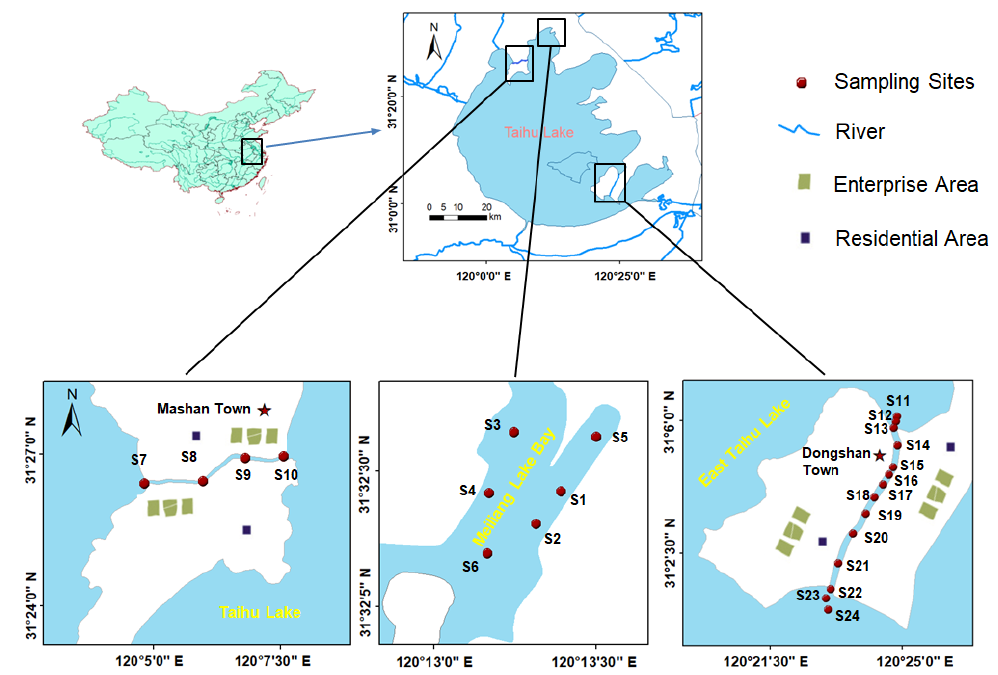
Figure1. Location of sampling sites in the lake bay and adjoining river of Taihu Lake. Figure 1. Location of sampling sites in the lake bay and adjoining river of Taihu